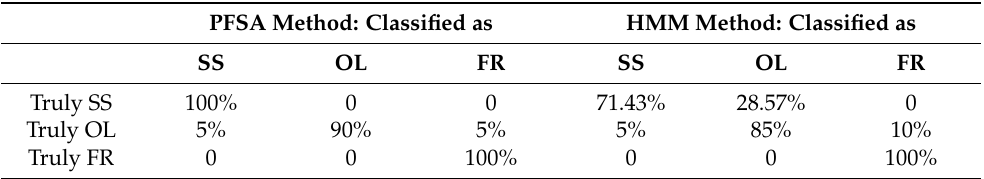
Figure 5. Case-wise classification accuracy for both datasets (without and with radiation) for HMM. Table 4. Confusion matrices showing the classification accuracy of the 33 time-series regimes from the dataset with radiation heat